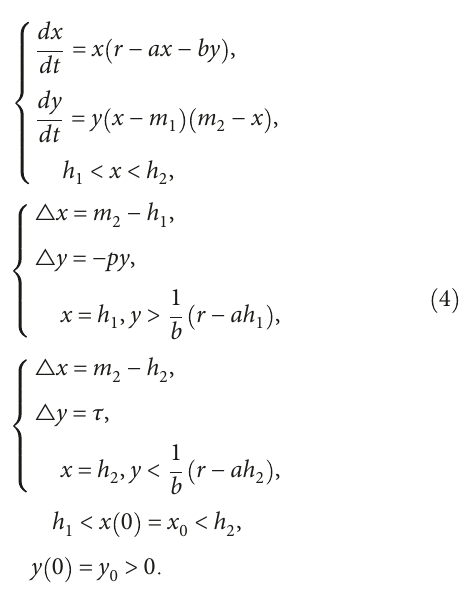
Figure 7: De fi ne the periodic solution of system (3).